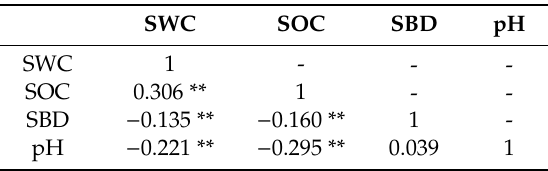
Table 2. The relationship among SWC, SOC, SBD and pH. SWC SOC SBD pH SWC